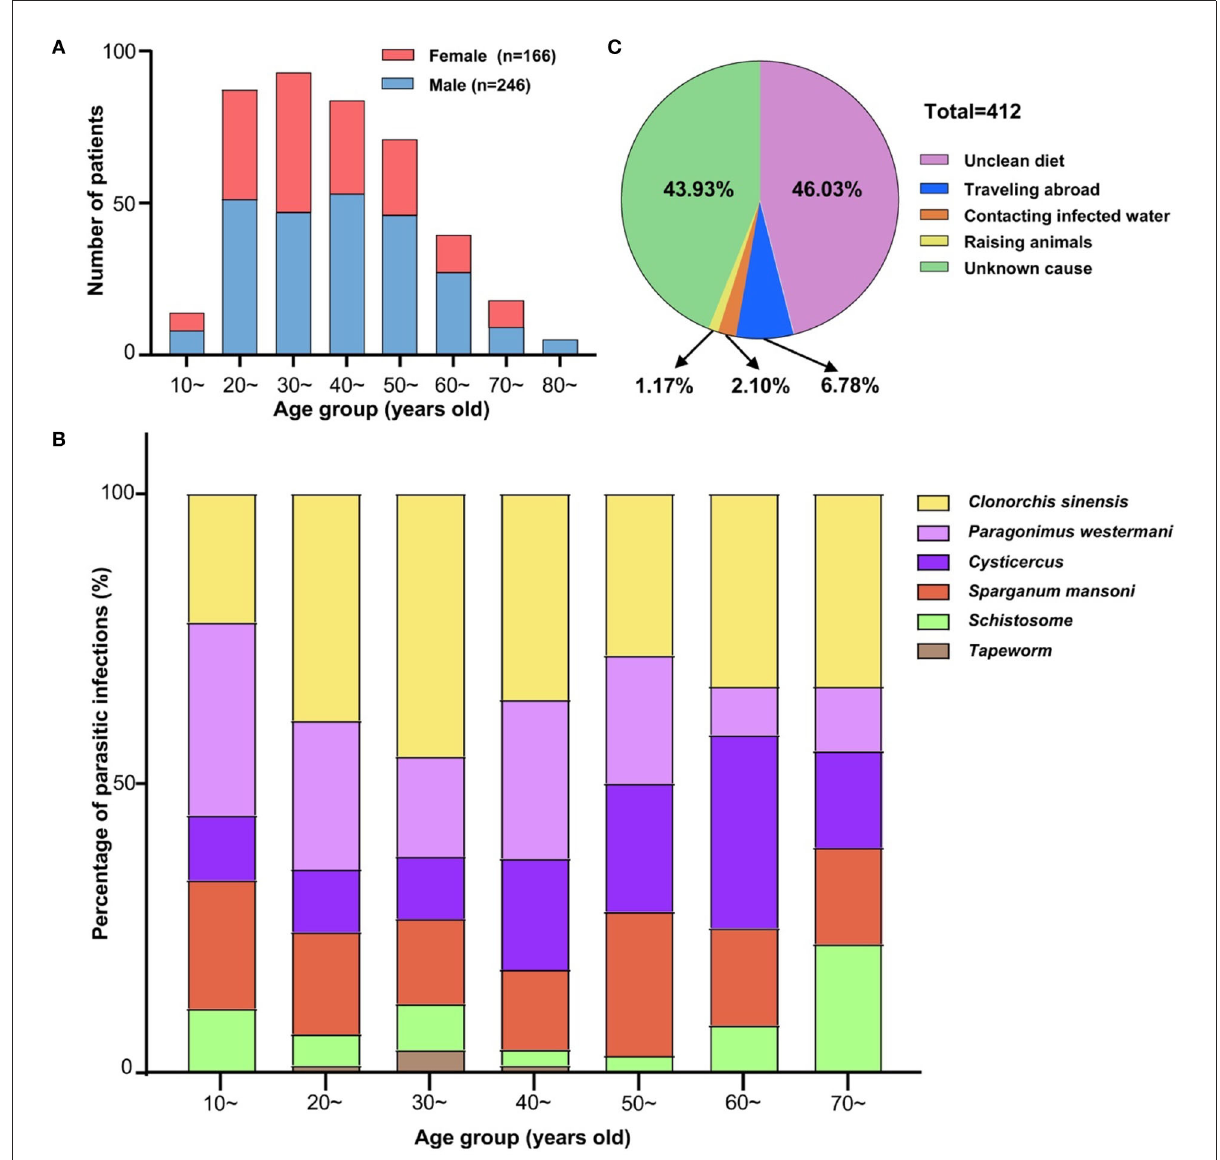
FIGURE3 Demographic characteristics of parasite-infected patients and the main routes of transmission. (A) Gender and age distribution of parasite-infected patients. Four hundred and twelve parasite-infected patients were categorized into nine different age groups. Male vs. female ratio was 1.48:1 with the age of 95% of patients ranging from 21 to 70. (B) Parasitic species with top six infections in different age groups. The prevalence of the top six parasitic infections showed a significant difference among different age groups ( χ 2 = 64.1, df = 30, P < 0.001). The proportion of Paragonimus westermani infections declined with age, while Cysticercus infections presented an increasing trend with age. (C) Main routes of transmission among parasite-infected patients. Four major routes of transmission were concluded here (Figure 3C): unclean diets (46.03%, 190/412); traveling abroad (6.78%, 28/412); contacting infected water (2.10%, 9/412); raising animals (1.19%, 5/412); and unknown infective ways (43.93%, 181/412).